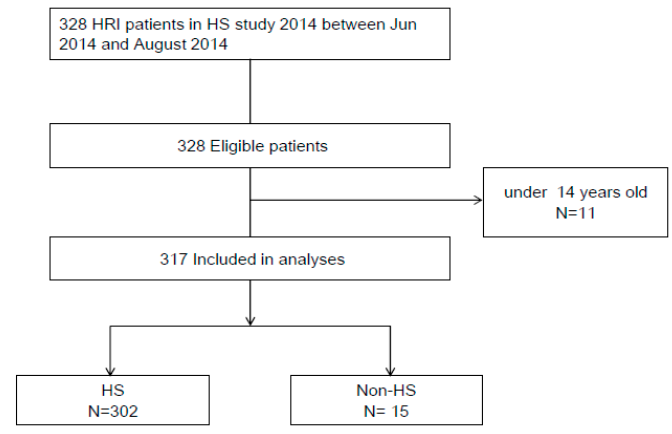
Figure 1. Patient enrollment and exclusion process of the study.